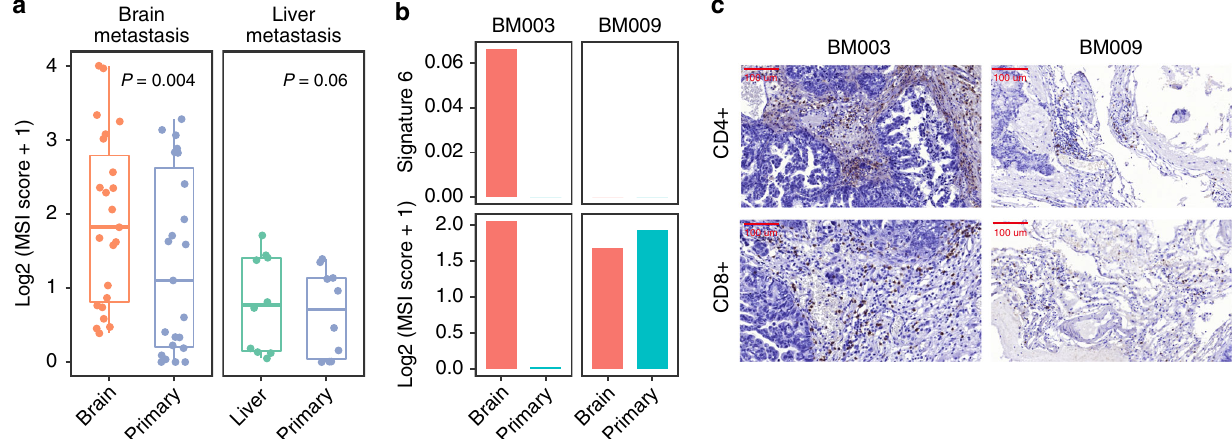
Fig. 3 MSI statuses and tumor-in fi ltrating lymphocytes in brain metastases and matched primary tumors of CRC patients. a MSI scores were signi fi cantly higher in BM tissues than in primary tissues but were not elevated in liver metastatic tissues. The box plot displays the fi rst and third quartiles (top and bottom of the boxes), median (band inside the boxes), and lowest and highest point within 1.5 times the interquartile range of the lower and higher quartile (whiskers). b , c Patient BM003 showed a consistent elevation of signature 6 mutations and the MSI score in BM tissues, whereas patient BM009 did not. In the brain tissues of patient BM003, there was a high degree of in fi ltration by CD4 + and CD8 + T